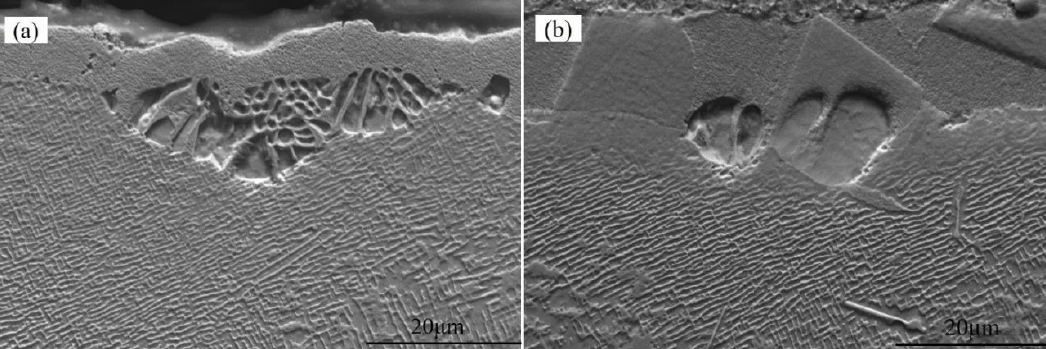
Figure 4. Specimen recrystallization morphology at 0.3 MPa sandblasting pressure in ( a ) uncoated and ( b ) coated alloys .